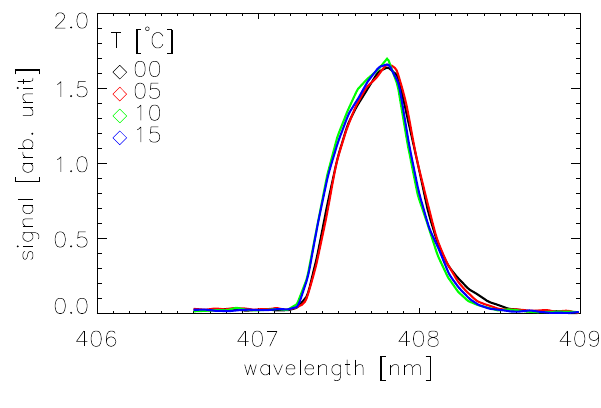
Fig. 2. Measurements with the Mini MAX-DOAS instrument of a Mercury line source at 407.8[nm], at four different